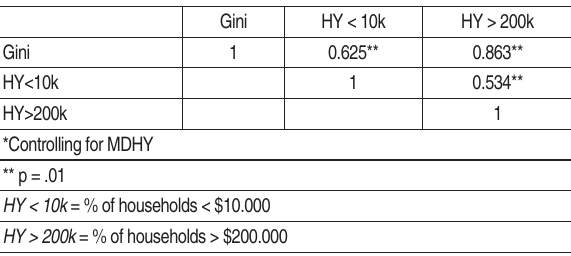
Table 2. Income distribution partial